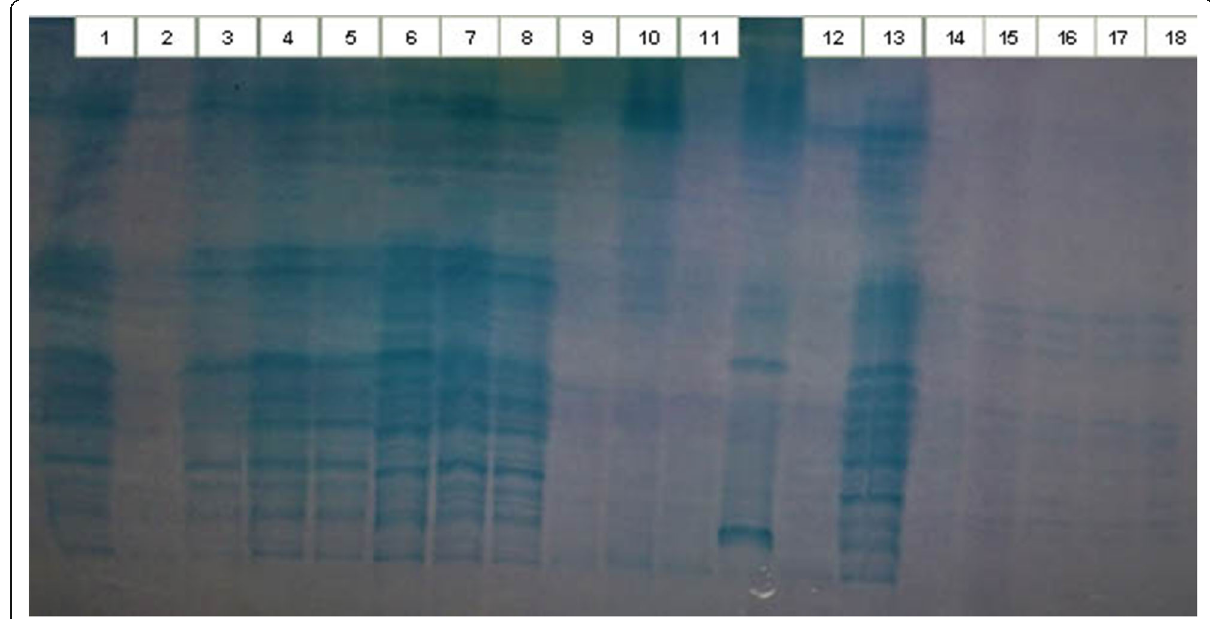
Fig. 1 Protein pattern of selected Pseudomonas isolates. 1: 4532, 2: 122,3: 642,4: 42,5: 4531,6: LN1112,7: 9421,8: S1121W,9: 8312,10: 1111,11: 12122,12: 1RN2,13: 12112,14: F7122,15: LN1111,16: 8311,17: 943,18: